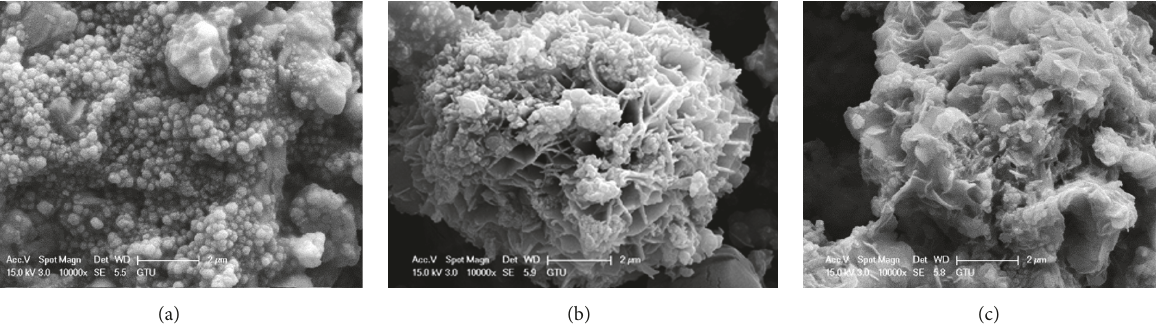
Figure 10: SEM micrographs of synthesized CIS powder at 240 ∘ C for (a) 10h, (b) 20 h, and (c) 40 h with